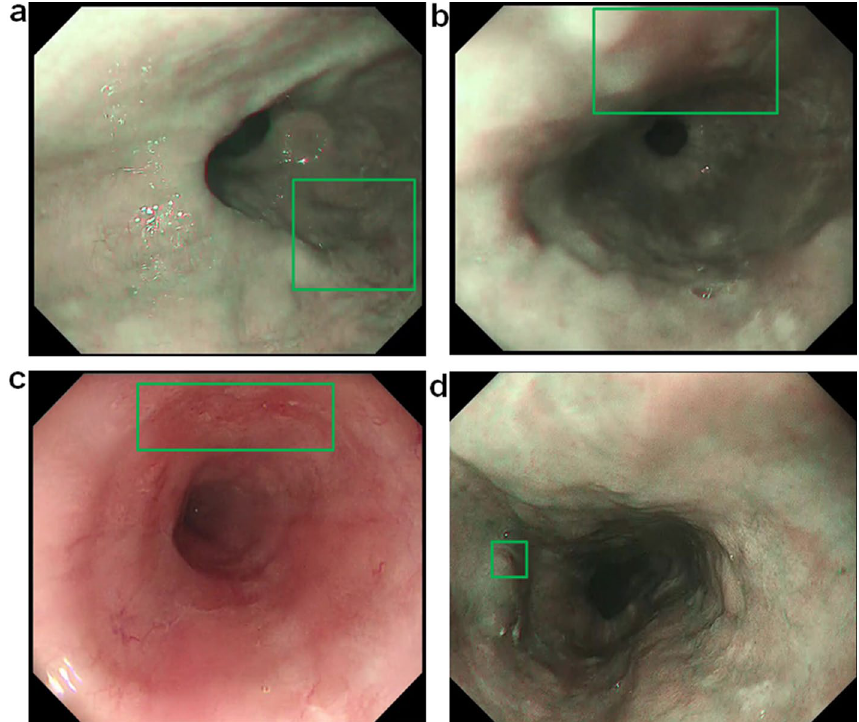
Figure 4. Examples of false-negative images. The cancers in the shown images were missed for the following estimated causes. ( a ) Inflammation of background mucosa, ( b ) anterior wall lesion, ( c ) obscure ESCC by WLI,